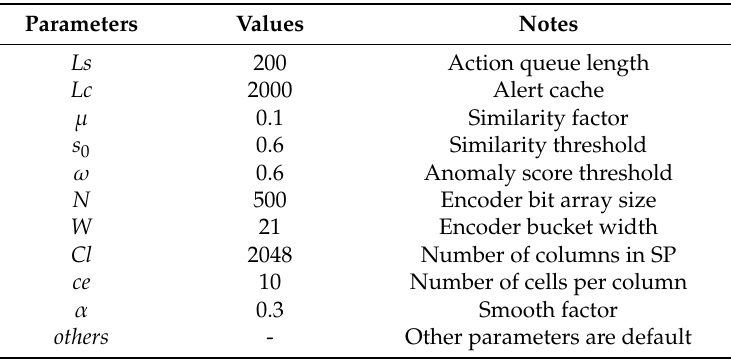
Table 1. Parameters set for the